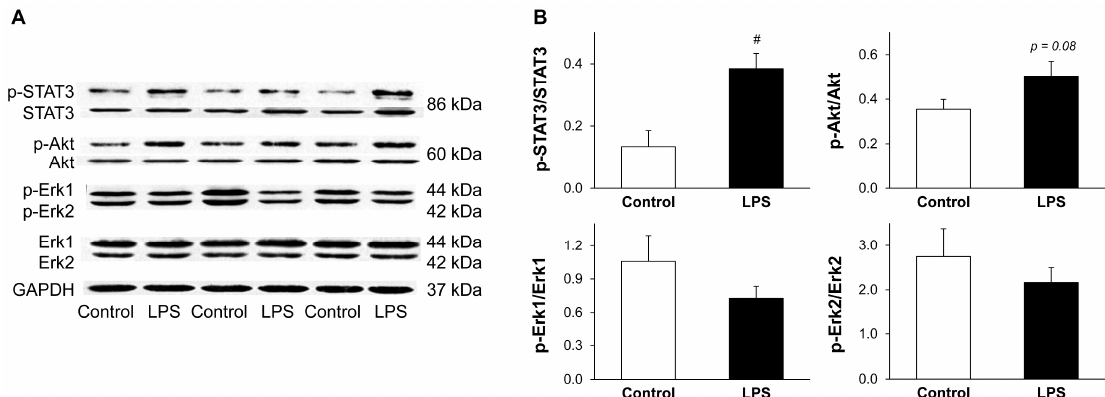
Figure 5. LPS pretreatment results in enhanced phosphorylation of STAT3. Figure shows representative images ( A ) and quantification ( B ) of western blots of possible cardiac pathways in LPS-induced delayed preconditioning. Analysis was performed 24 h after in vivo 0.5 mg/kg low-dose lipopolysaccharide (LPS) treatment. Values are expressed as mean ± S.E.M. ( n = 7 in each groups). # p < 0.05 vs. control, unpaired t -test. p-STAT3: phospho(Tyr705)-STAT3, p-Akt: phospho(Ser473)-Akt, p-Erk1/2: phospho(Thr202/204)-Erk1/2, GAPDH: glyceraldehyde 3-phosphate dehydrogenase